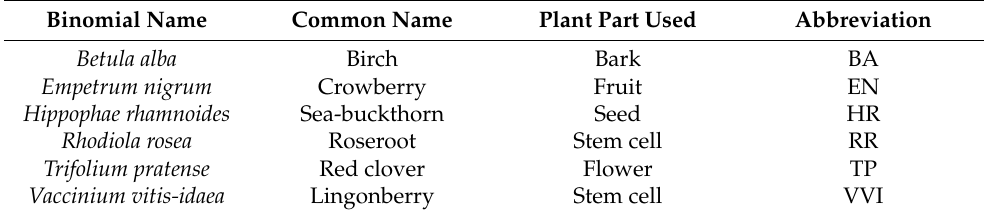
Table 1. List of six Scandinavian plants, and the resulting plant extracts. Binomial Name Common Name Plant Part